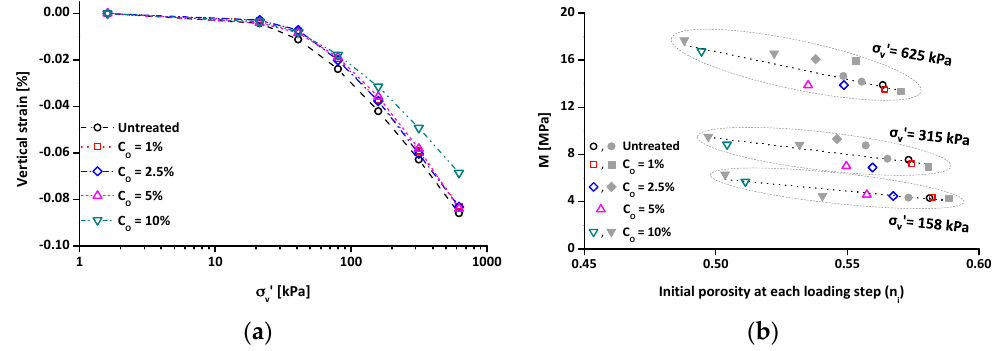
Figure 9. Zero-lateral strain oedometer experiment results: ( a ) stress-strain curves; and ( b ) constrained modulus (M) with initial porosity at each loading step (n i ). Note that data (closed symbols in Figure 9b) indicate the M values of the untreated and treated clay specimens with various initial porosities due to different tamping energies.